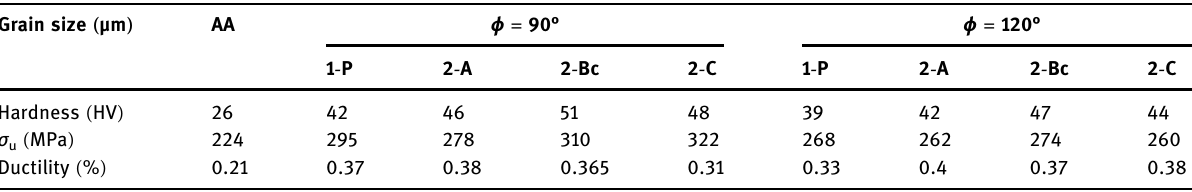
Table 2: Mechanical properties of the AA and ECAPed samples using di ff erent die angles, ϕ of 90° and 120°, and di ff erent route types, A, Bc, and C Grain size ( µm